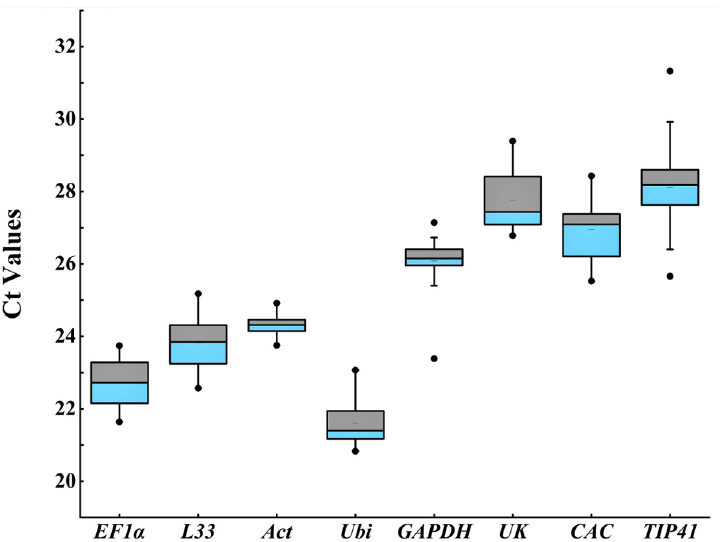
Figure 2. Distribution of Ct values of eight candidate reference genes in tomato. Black circles represent the maximum and minimum values.